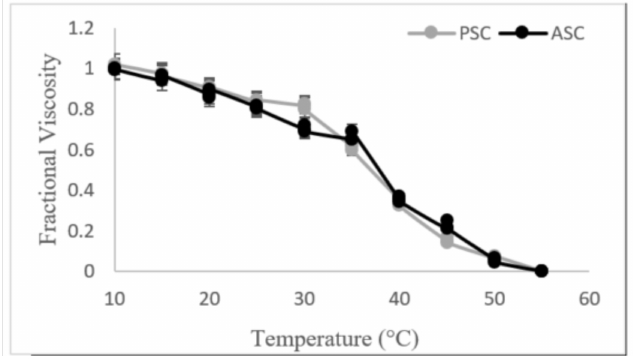
Figure 3. Variations in the fractional viscosity of acid-soluble collagen (ASC) and pepsin-soluble collagen (PSC) from catfish skin as a function of temperature.